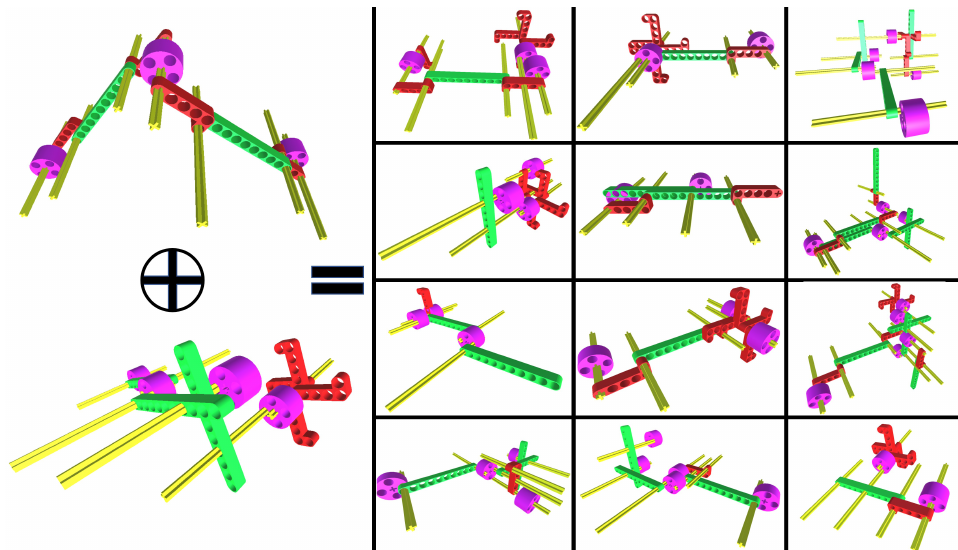
Figure 8. An example result of the crossover operation in our system. Crossing-over the left two assemblies yielded the twelve new assemblies on the